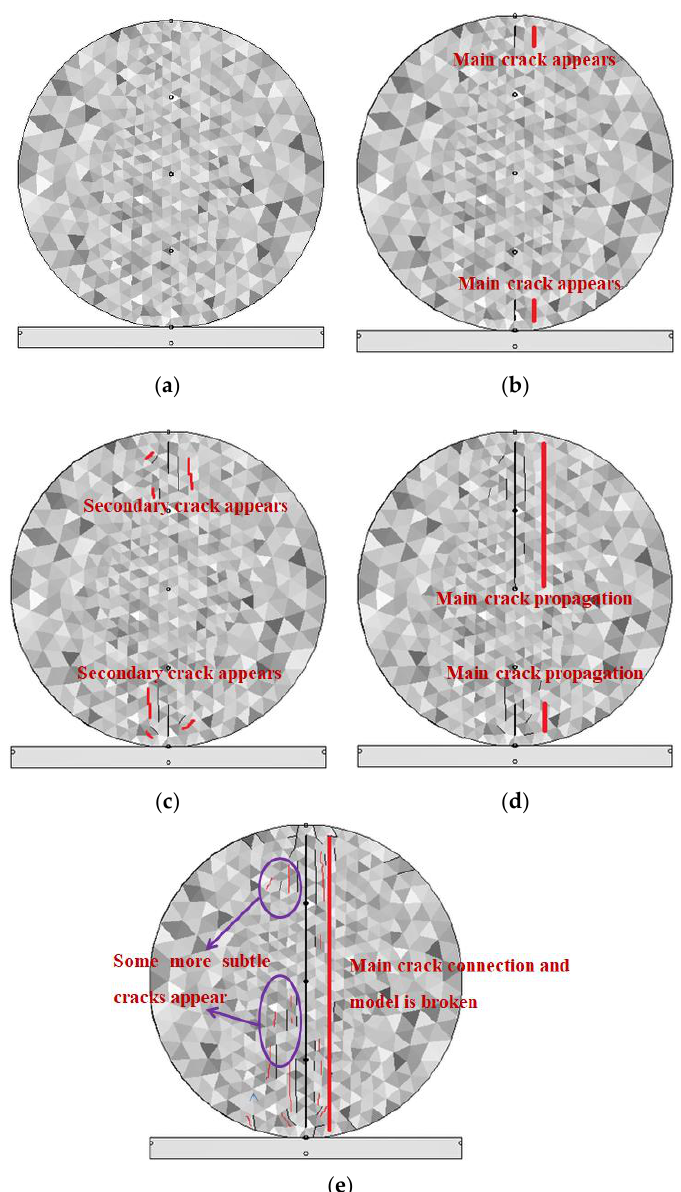
Figure 5. Optimized DDARF simulates the disc failure process of the Brazilian disc-splitting ex- periment: ( a ) The model in optimized DDARF; ( b ) Vertical main cracks appeared firstly in the top and bottom of the model; ( c ) Some secondary cracks appeared next to the main cracks; ( d ) Vertical main cracks continued to expand vertically; ( e ) Vertical main cracks broke through, resulting in the destruction of the model.